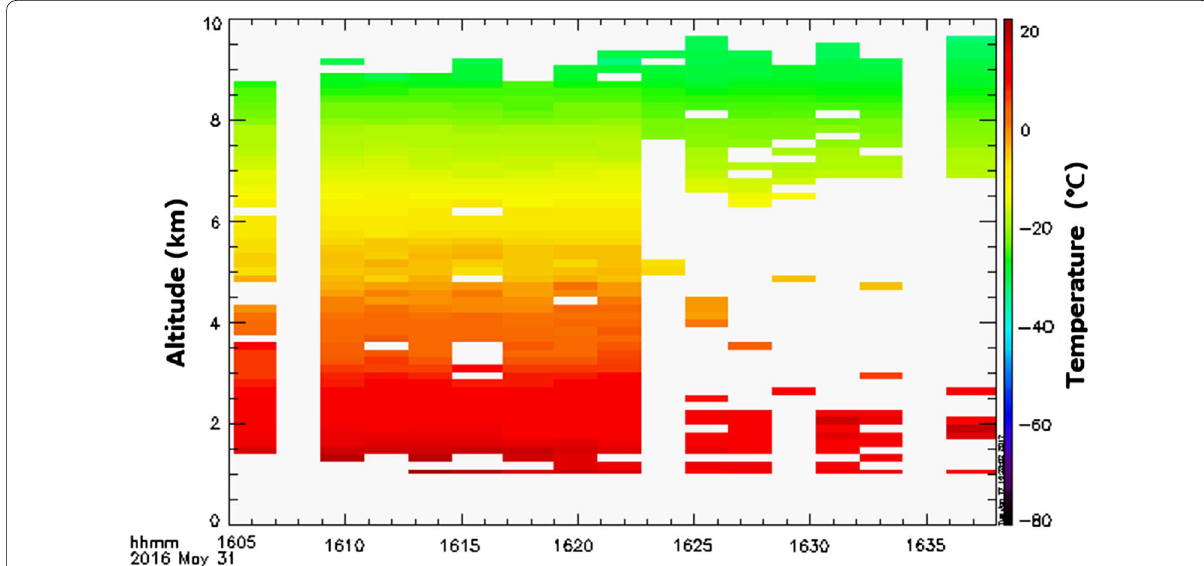
Fig. 10 Time and height variations of the temperature observed with EAR–RASS from 16:05 to 16:38 LT on May 31, 2016. Sweep range of the FM- chirped acoustic signals was changed at 16:23 LT (see